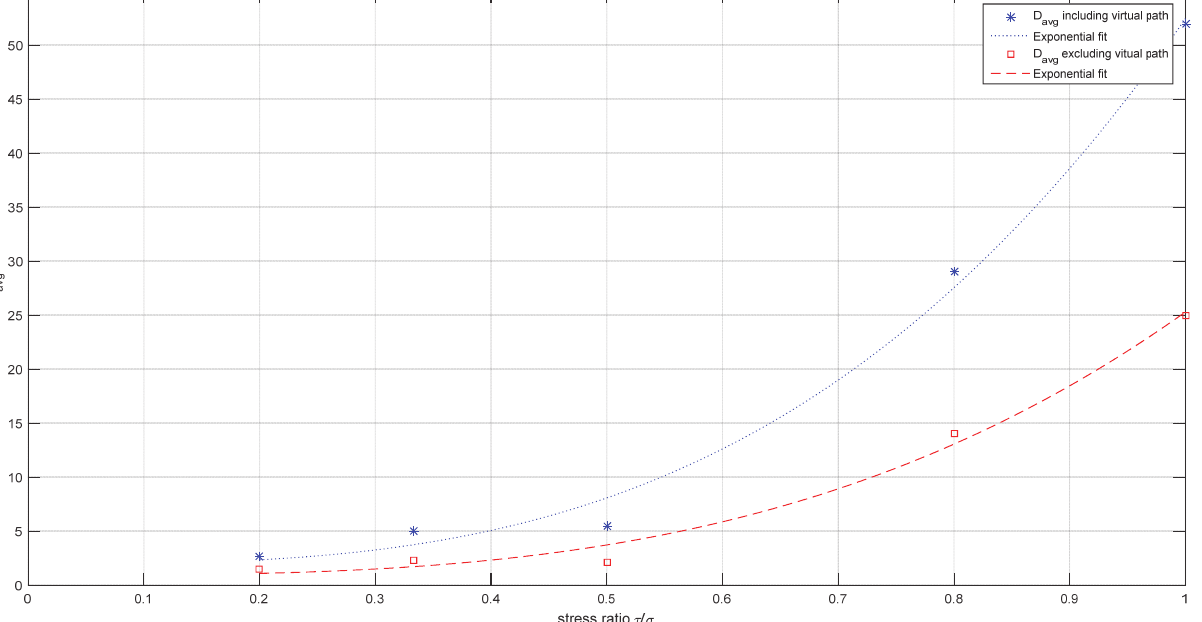
Figure 12: Graph showing the exponential increase of fatigue damage with increasing stress amplitude ratio considering PDMR based cycle